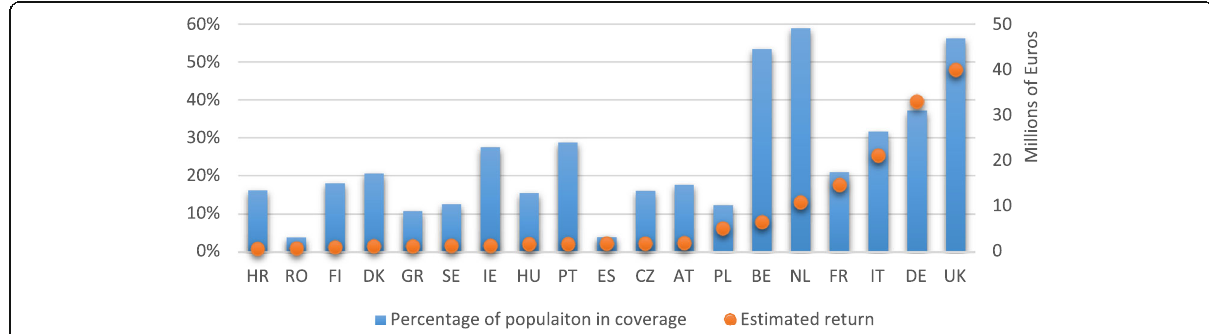
Fig. 17 Percentage of population covered by drone service (left axis) and estimated return of drone delivery hives per country (right axis) for Scenario 4 and a 650,000-euro economic viability threshold